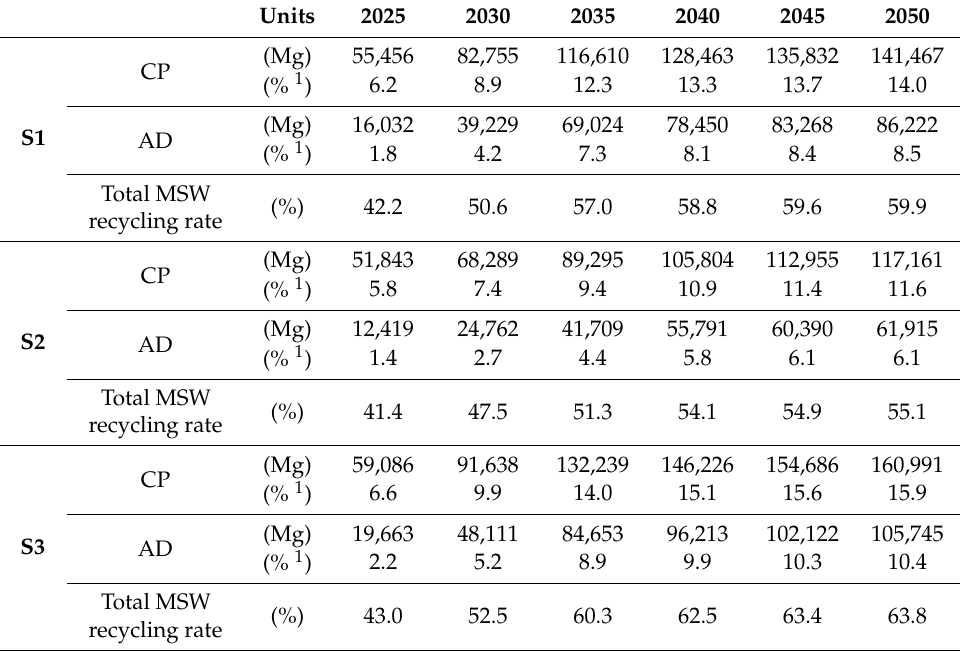
Table 6. TS ‐ III material flow of biowaste in recycling process and MSW recycling rate achieved.